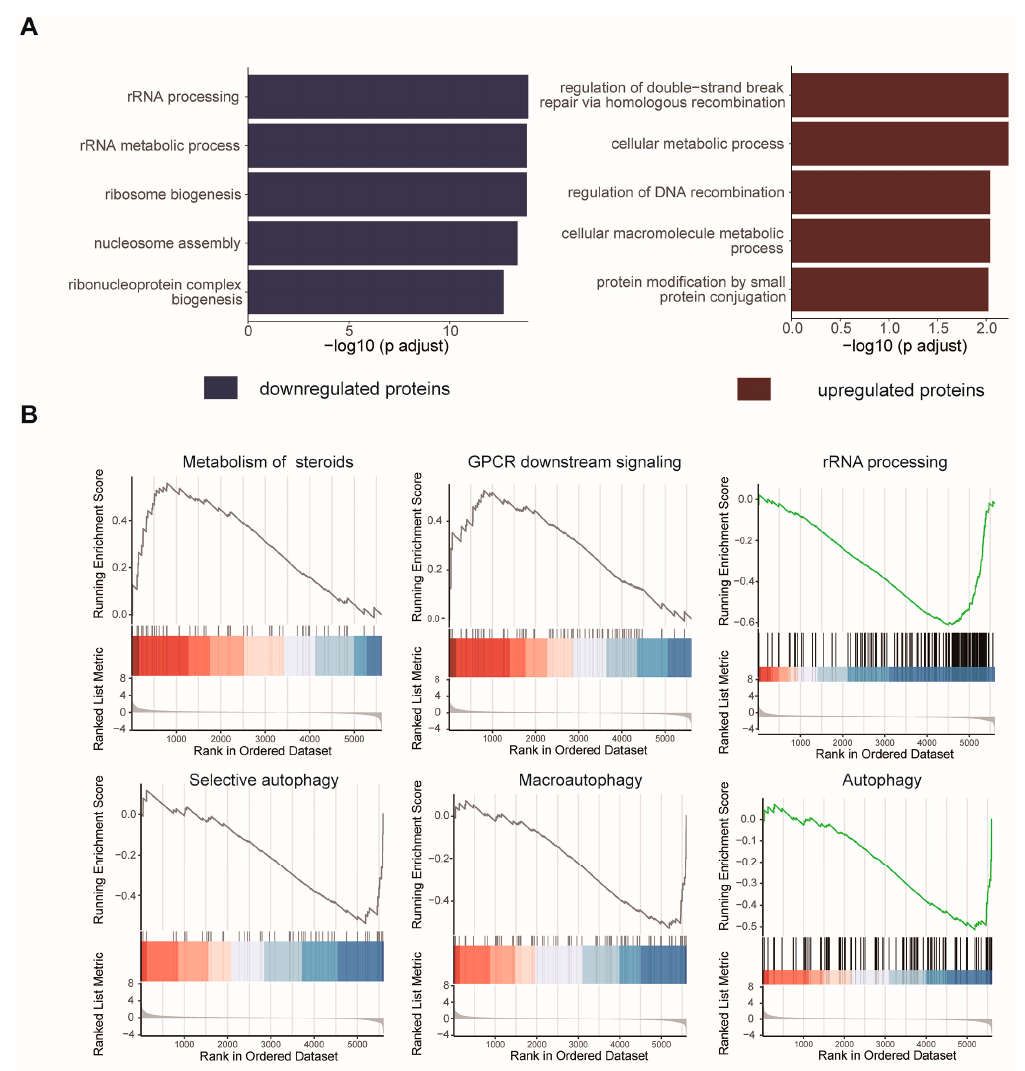
Figure 4. The biological functions and pathways influenced by the differentially expressed proteins.